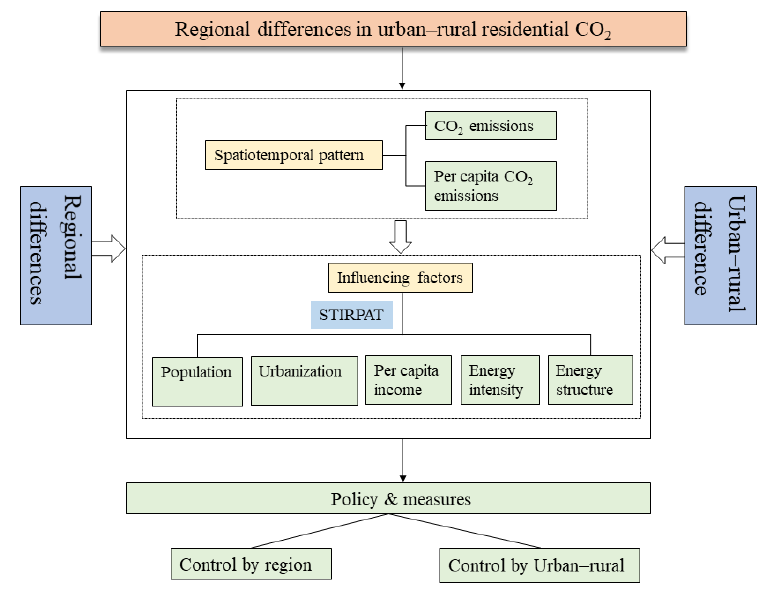
Figure 2. Research and analytical framework.